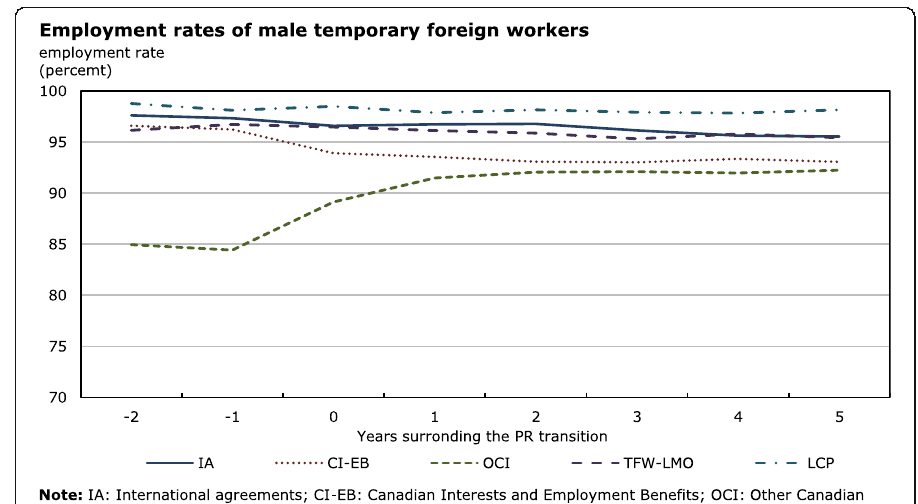
Fig. 1 Employment rates of male temporary foreign workers. Sources: Statistics Canada, Temporary Residents file, Immigrant Landing file and Canadian Employer-Employee Dynamics